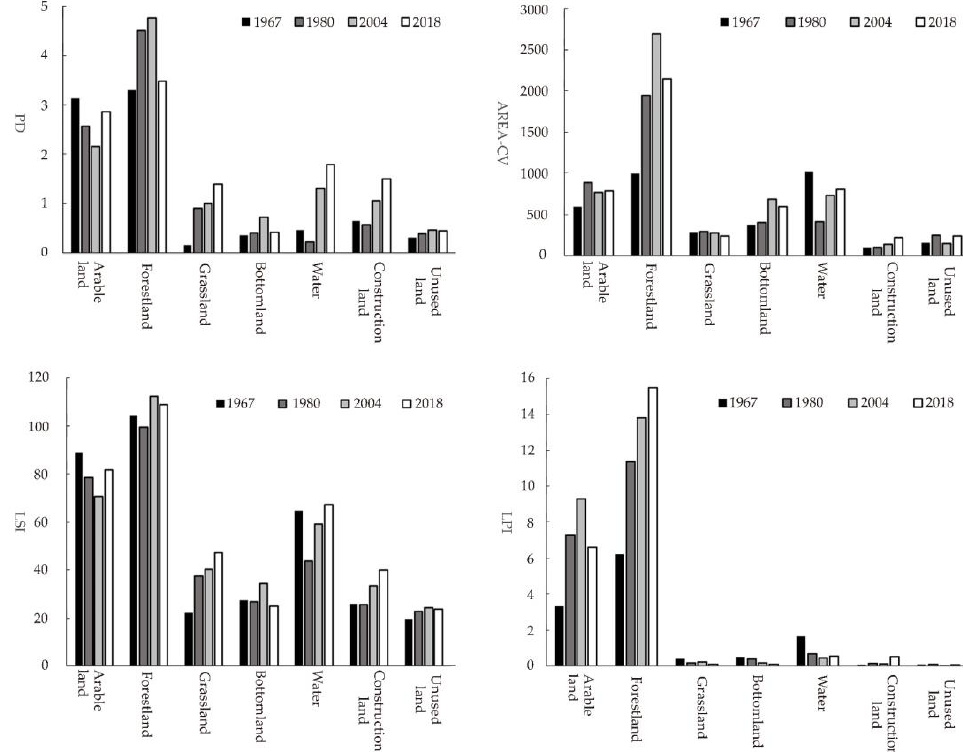
Figure 6. Landscape pattern indices of different land use types.